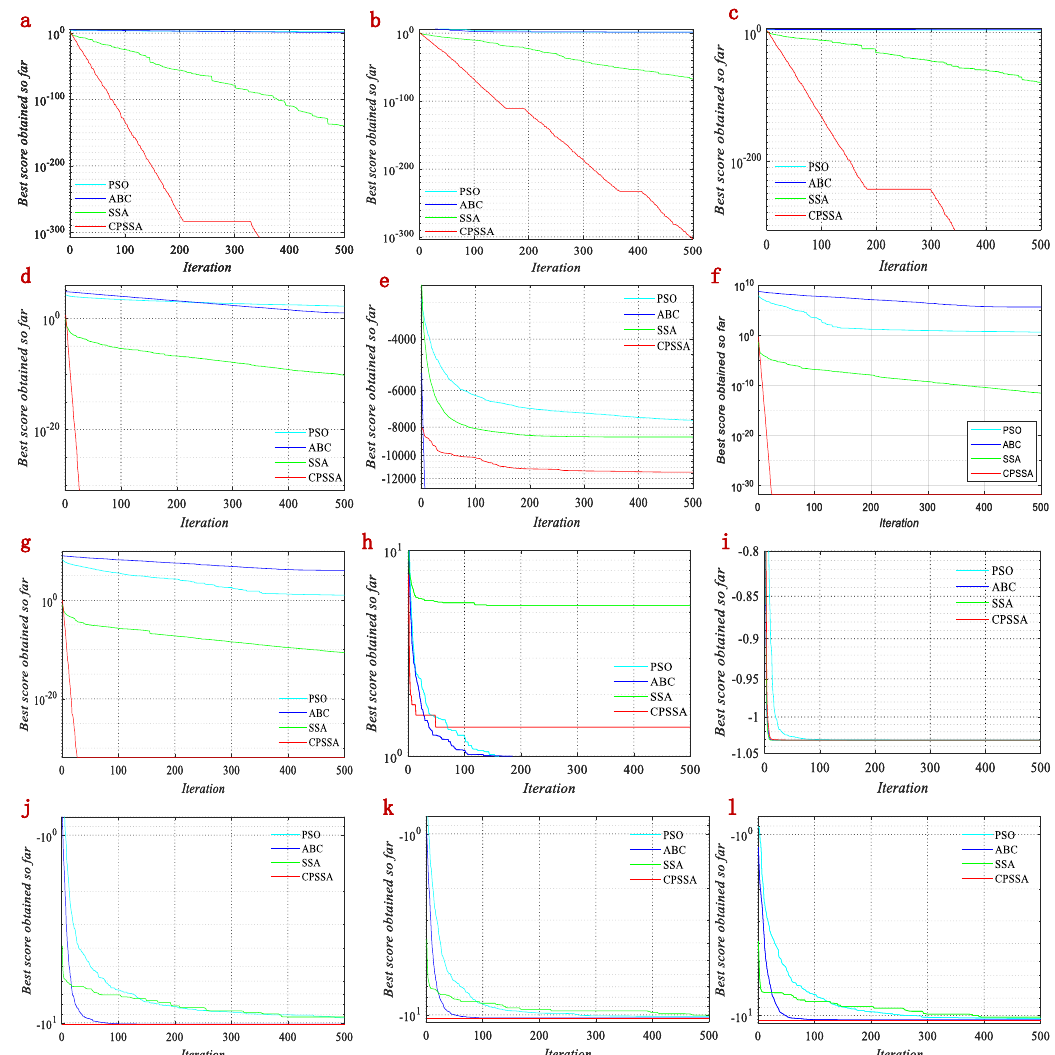
Figure 4. Convergence curves of four algorithms on twelve test functions. ( a ) F1; ( b ) F2; ( c ) F3; ( d ) F4; ( e ) F5; ( f ) F6; ( g ) F7; ( h ) F8; ( i ) F9; ( j ) F10; ( k ) F11; ( l )